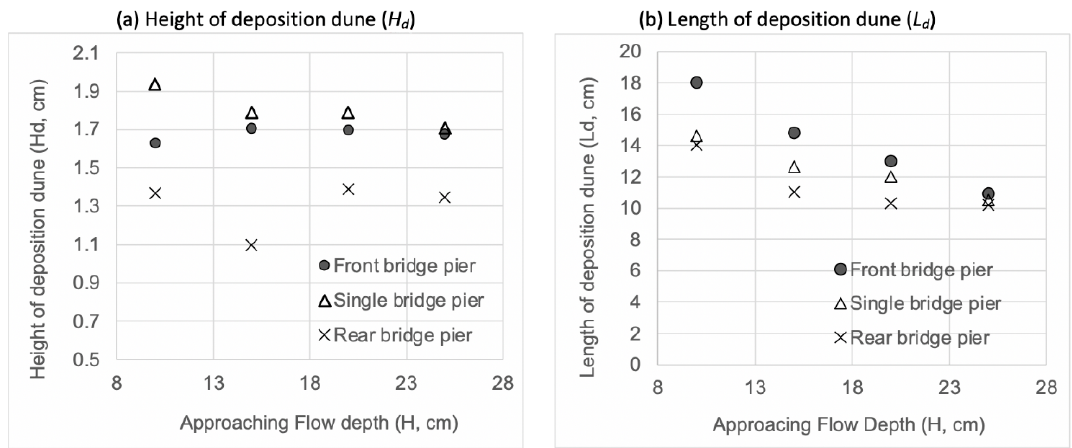
Figure 6. The height and length of deposition dunes downstream of tandem double piers compared to those of a single pier ( V = 0.2 m/s, L = 24